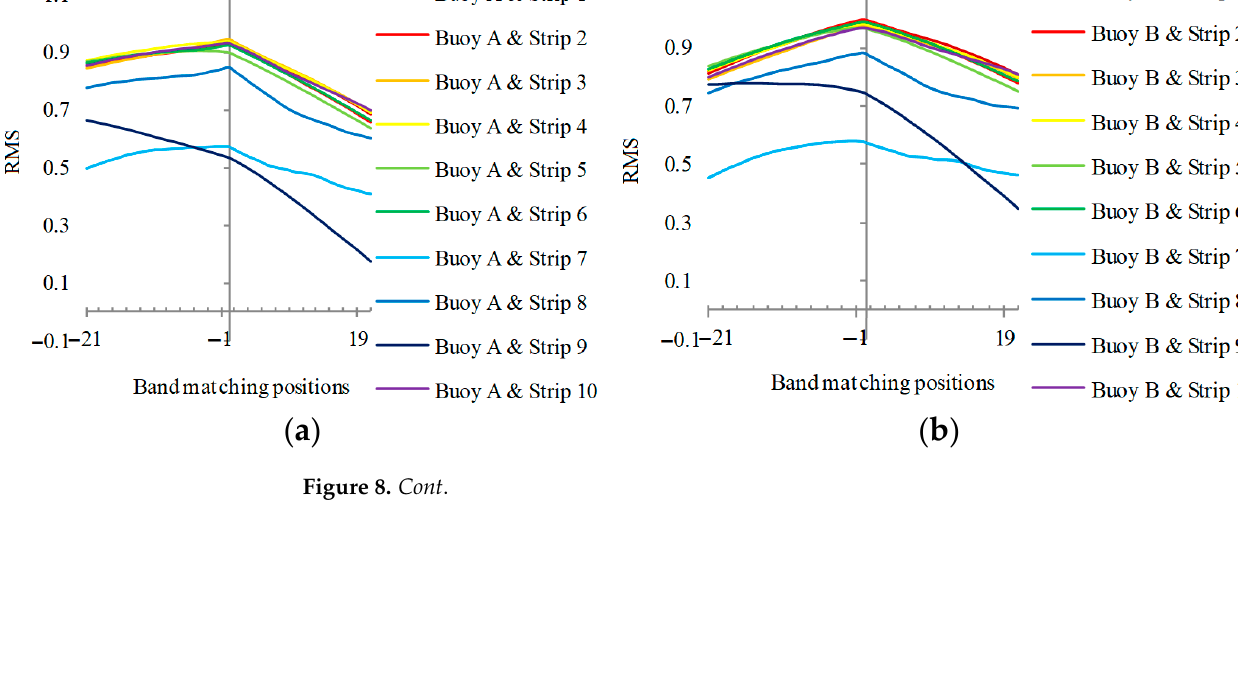
Figure 7. Comparison of mean reflectance between the data of two buoy spectrometers and 10 strips of UAV.